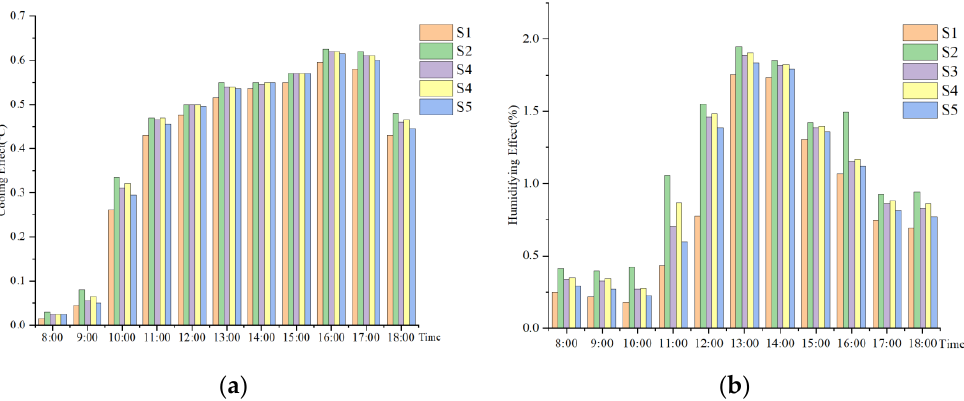
Figure 19. Cooling and humidifying effect of each square scheme: ( a ) Cooling effect; ( b ) Humidify- ing effect.